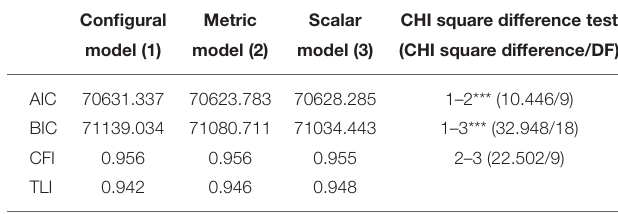
TABLE 4 | Measurement fit for the distinguished invariance models ( N = 2,082).